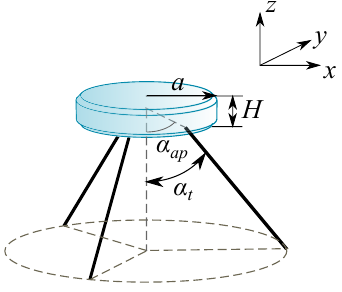
Figure 1. A three-tether wave energy